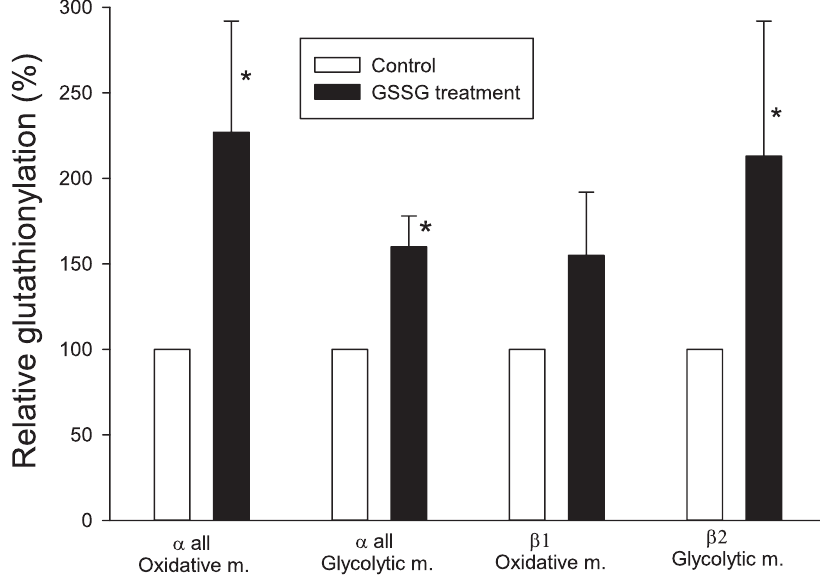
Figure 3. GSSG-induced changes in relative glutathionylation level. Rat muscle homogenates from oxidative and glycolytic muscle were incubated in 5 mM GSSG for 20 min, immunoprecipitated with an anti-GSH antibody, and the Na,K-ATPase subunits were quantified by Western blotting. Examples of gel pictures are provided in the S1 file. The glutathionylation was calculated relative to the control. n=6 in all groups. *: significantly different from control (P , 0.05). The difference for b 1 oxidative muscle is not different (P=0.05).